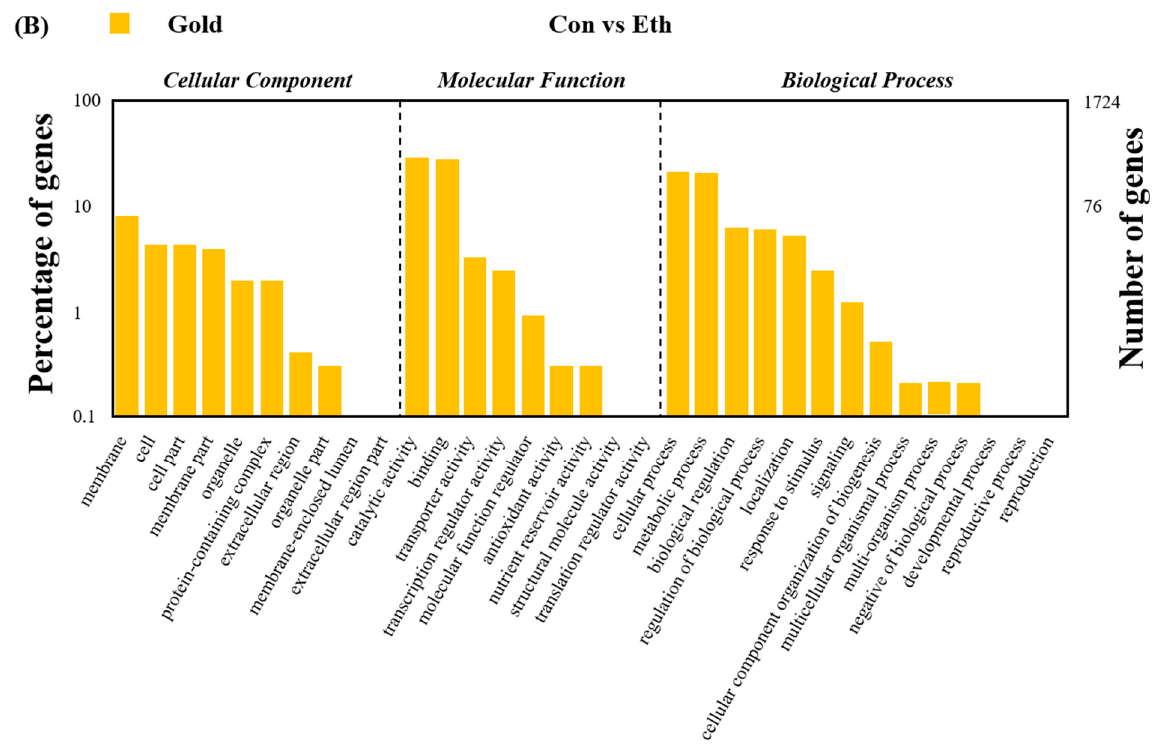
Figure 1. GO classification of the DEGs of control vs. ethylene in ( A ) green ‘Hayward’ and ( B ) gold ‘Haegeum’ kiwifruit.